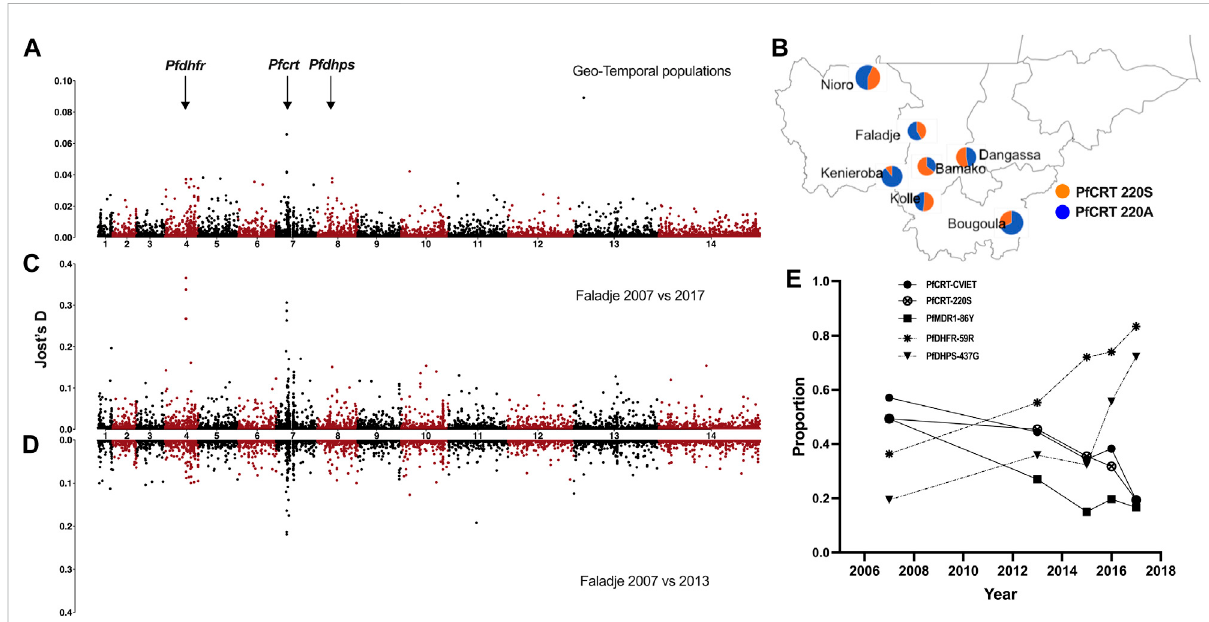
FIGURE 3 Genome-wide SNP differentiation between geo-temporal populations of P. falciparum from Mali. (A) Manhattan plotof genome-wideJost ’ sD differentiation index per SNP between all sampling locations (geo-temporal populations) in Mali. The genomic location of drug-resistance- associated genes ( pfdhfr , pfcrt , and pfdhps ) is indicated with arrows. (B) Allele frequency proportions (pie charts) for the PFCRT A220S locus across differentsamplinglocations. (C) Manhattanplotofgenome-wideJost ’ sDdifferentiationindexperSNPbetweensamplesfromFaladjecollected in 2007 and 2015 – 2017 and (D) Faladje 2007 against 2013. (E) Temporal changes in proportion of alleles and haplotypes of drug-resistance- associated loci in pfdhfr , pfcrt , and pfdhps